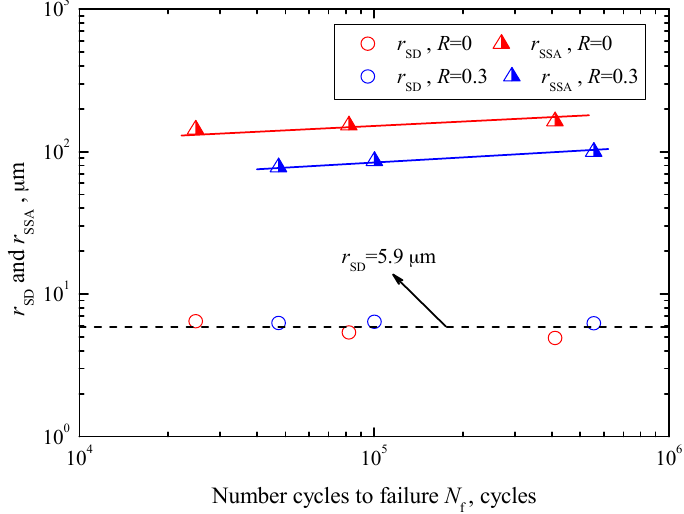
Figure 9. Relationships between r SD and r SSA , and N f .